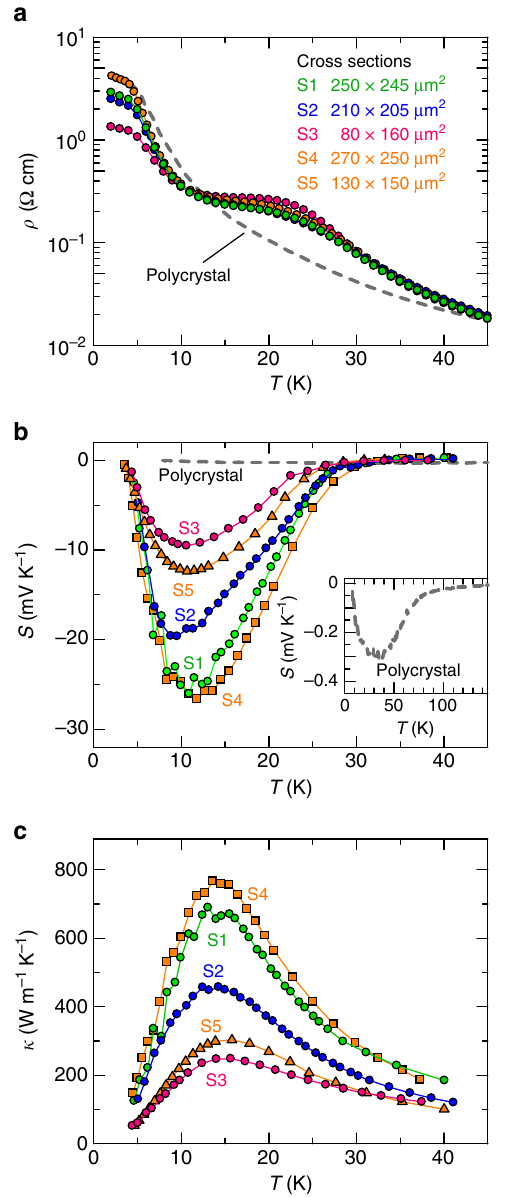
Figure 2 | Sample size effect on the electrical and thermal transport properties. ( a ) Temperature dependence of electrical resistivity. ( b , c ) Temperature dependence of Seebeck coefficient and thermal conductivity. Both properties show a striking size dependence in the high-purity single crystals. r and S for the low-purity polycrystalline sample are plotted as grey lines in a , b ,